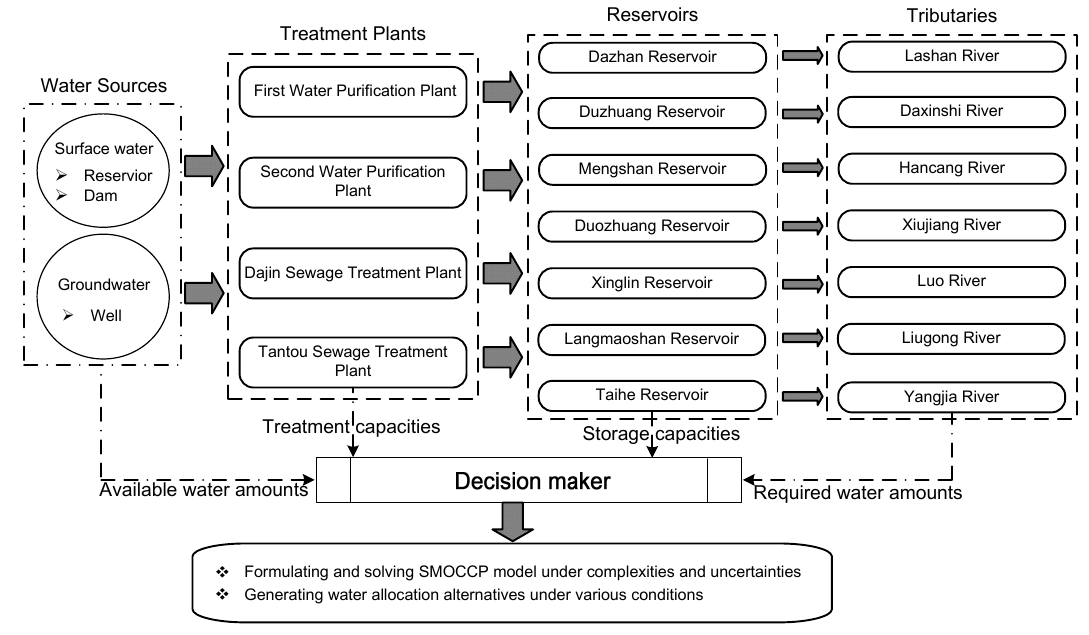
Figure 3. Flow diagram of the water supply management system in the watershed.